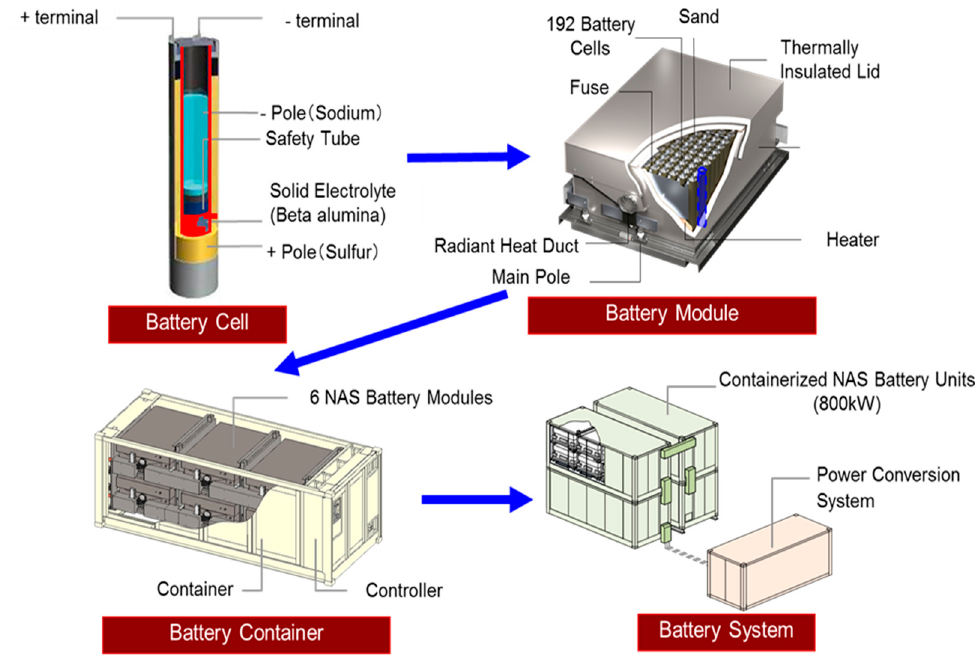
Figure 6. NaS battery